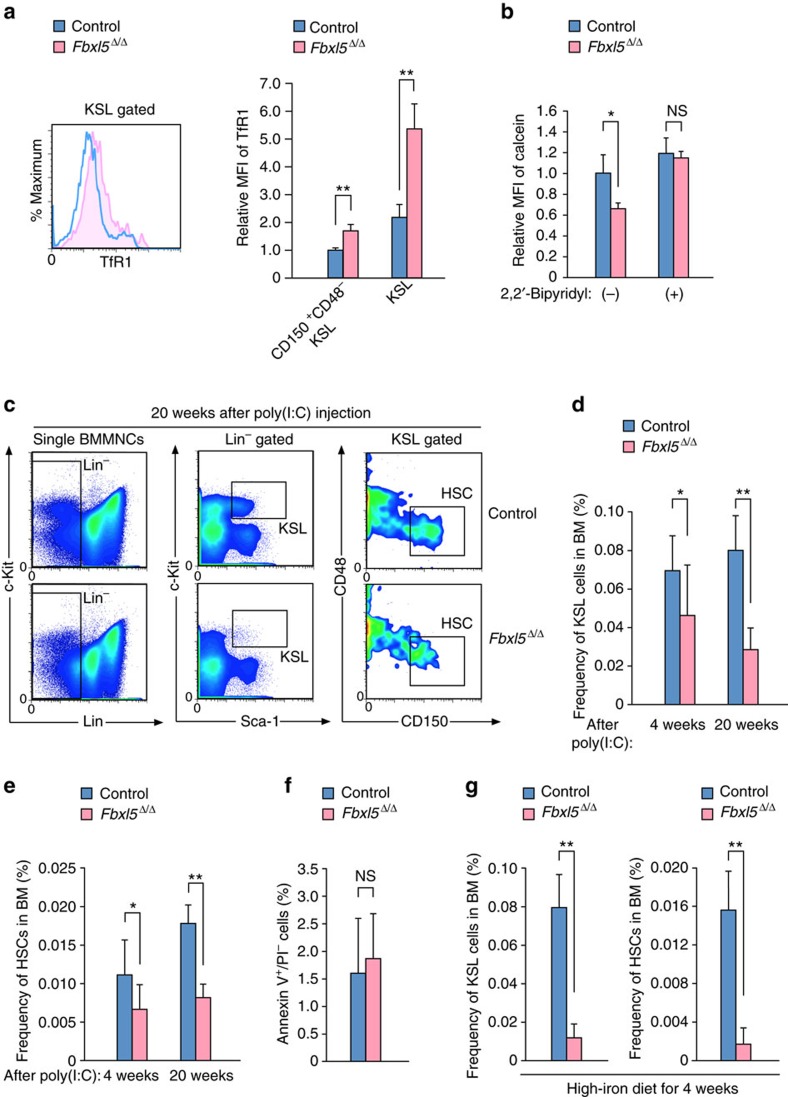
Cellular iron homeostasis is essential for the maintenance of HSCs.(a) Representative flow cytometric analysis of TfR1 on the surface of Fbxl5Δ/Δ or control KSL cells (left), and relative mean fluorescence intensity (MFI) of TfR1 on the surface of Fbxl5Δ/Δ or control KSL cells or HSCs (right, n=3). (b) Flow cytometric analysis of calcein fluorescence in Fbxl5Δ/Δ or control KSL cells exposed or not to 2,2′-bipyridyl (n=3). (c) Gating strategy for isolation of KSL cells and HSCs from BM mononuclear cells (BMMNCs) of Fbxl5Δ/Δ or control mice at 20 weeks after the last poly(I:C) injection. (d,e) Frequency of KSL cells (d) or HSCs (e) among BM cells of Fbxl5Δ/Δ or control mice at 4 weeks (n=9) or 20 weeks (n=4) after the last poly(I:C) injection. (f) Frequency of apoptotic [annexin V+/propidium iodide (PI)–] cells among Fbxl5Δ/Δ or control HSCs in BM at 4 weeks after the last poly(I:C) injection (n=3). (g) Frequency of KSL cells or HSCs among BM cells in lethally irradiated mice reconstituted with Fbxl5Δ/Δ or control BM cells (1 × 106) and fed a high-iron diet for 4 weeks (n=5). Data are means+s.d. *P<0.05, **P<0.01 (Student’s t-test); NS, not significant.